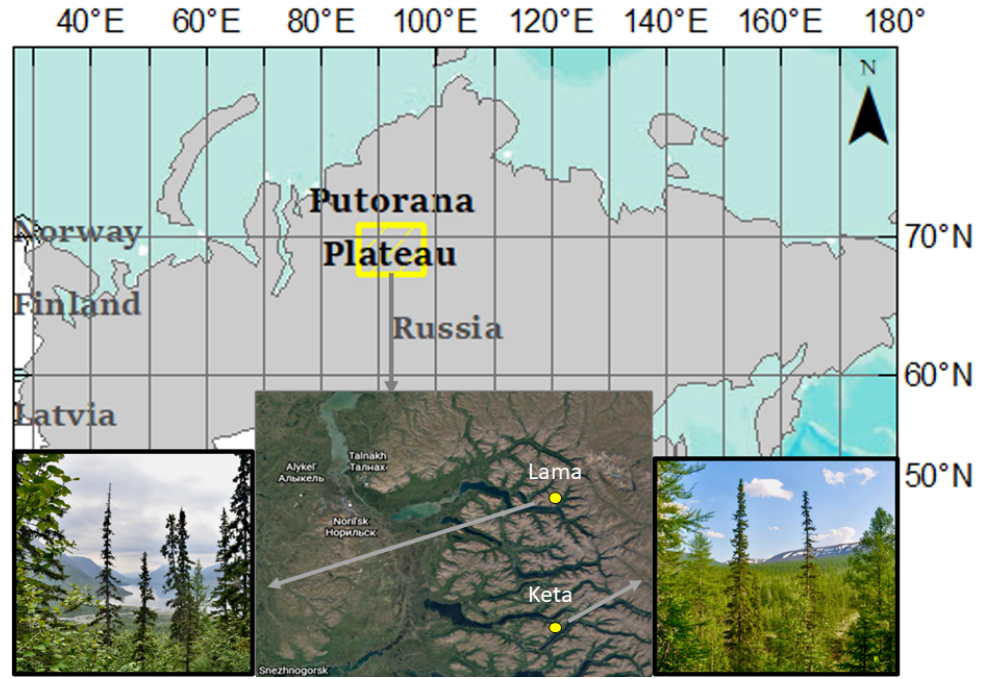
Figure 1. Position of the sample locations in Russia: the lakes Lama and Keta (Krasnoyarsk region).